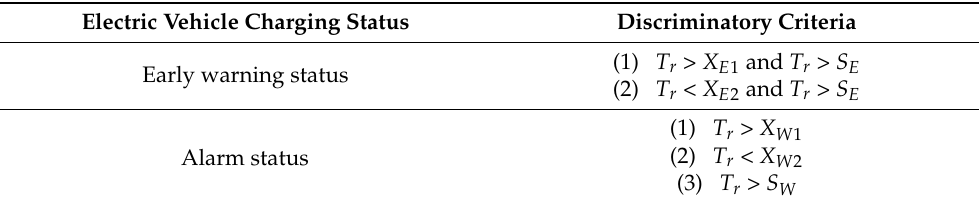
Table 4. Criteria for judging the charging status of electric